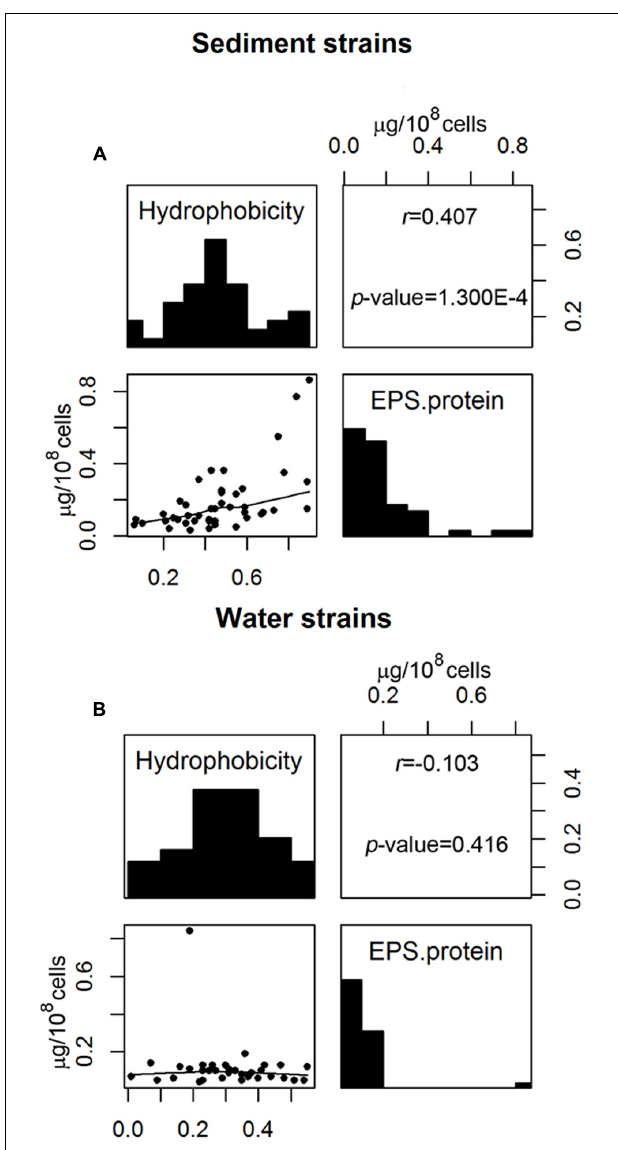
FIGURE 4 | Correlation between E. coli hydrophobicity and EPS protein content for (A) sediment E. coli strains and (B) water E. coli strains. The upper panels show the correlation coefficient r with associated p -value analyzed by Kendall-tau method; the diagonal panels show histograms of each property; the lower panels are scatterplots with the smoothing curves using the Lowess